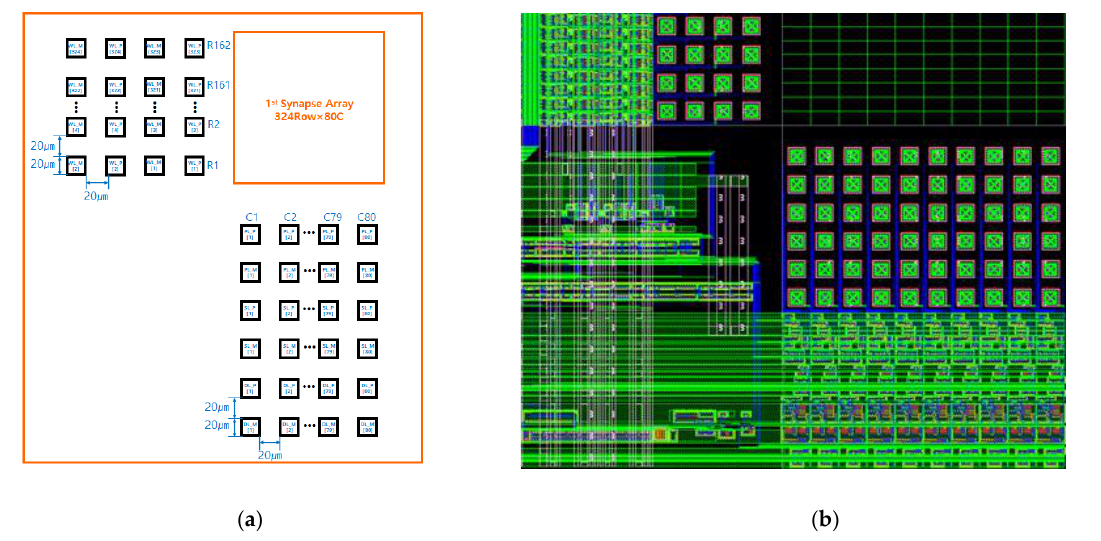
Figure 13. Hybrid bonding technology.